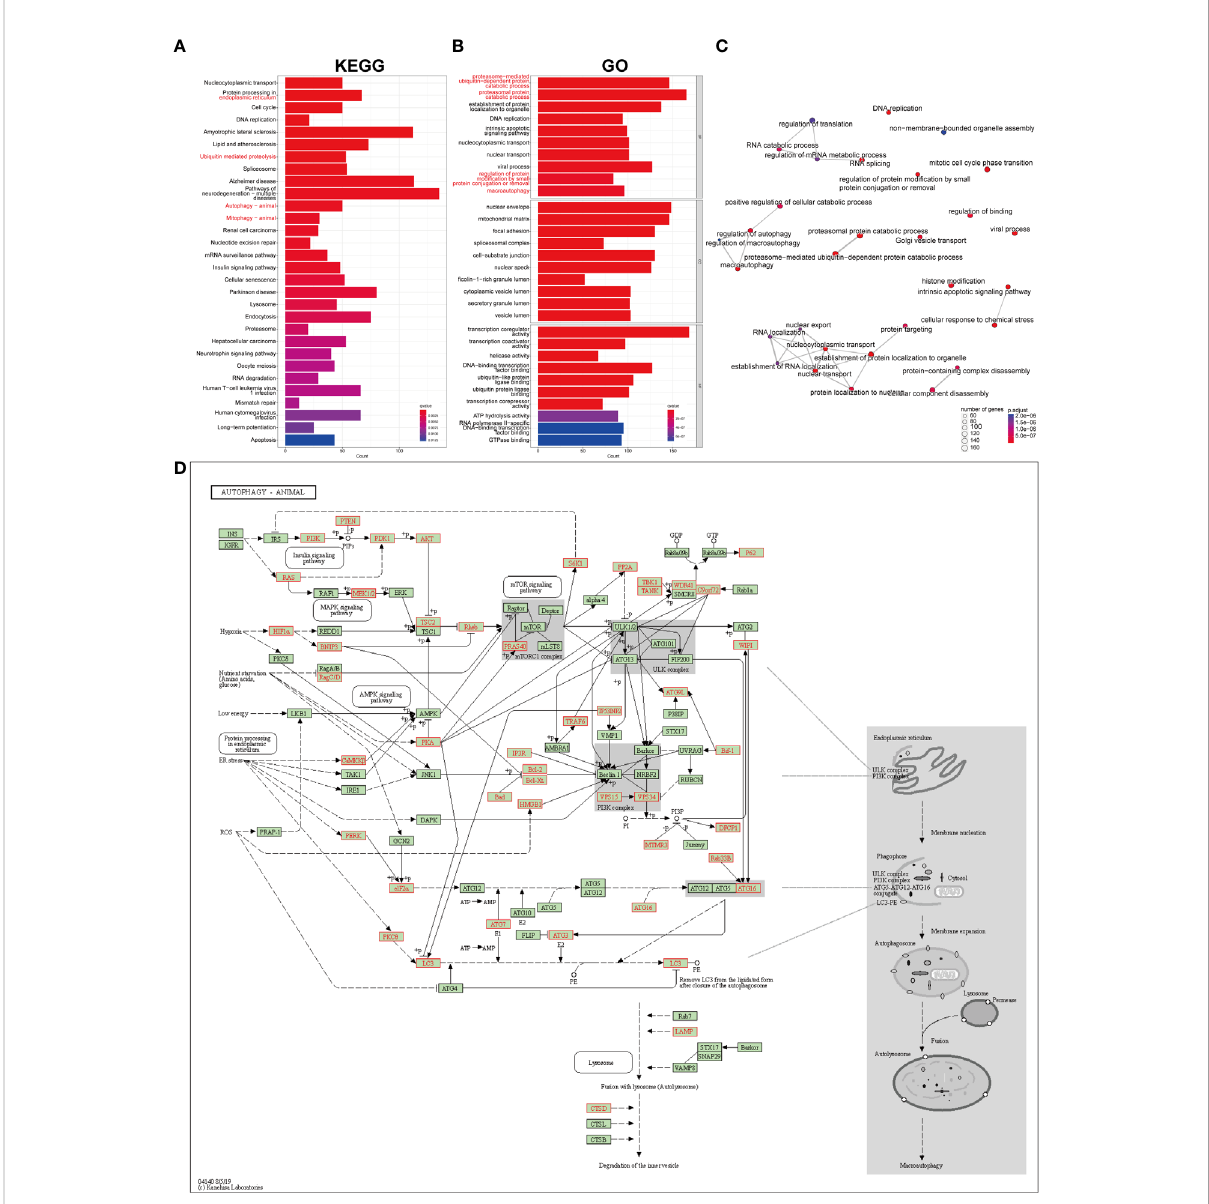
FIGURE 5 GO and KEGG pathway enrichment analysis on the genes mediated by key pSS-related m6A regulators. (A) The signi fi cantly enriched top 30 KEGG pathways. (B) The signi fi cantly enriched top 10 terms for GO: are BP, CC, and MF. (C) The emapplot visualizes gene sets of biological processes as a network, mutually overlapping gene sets tend to cluster together, making it easier for interpretation. Top 30 GO: BP terms were presented. (D) The “ Autophagy-animal ” pathway identi fi ed with KEGG